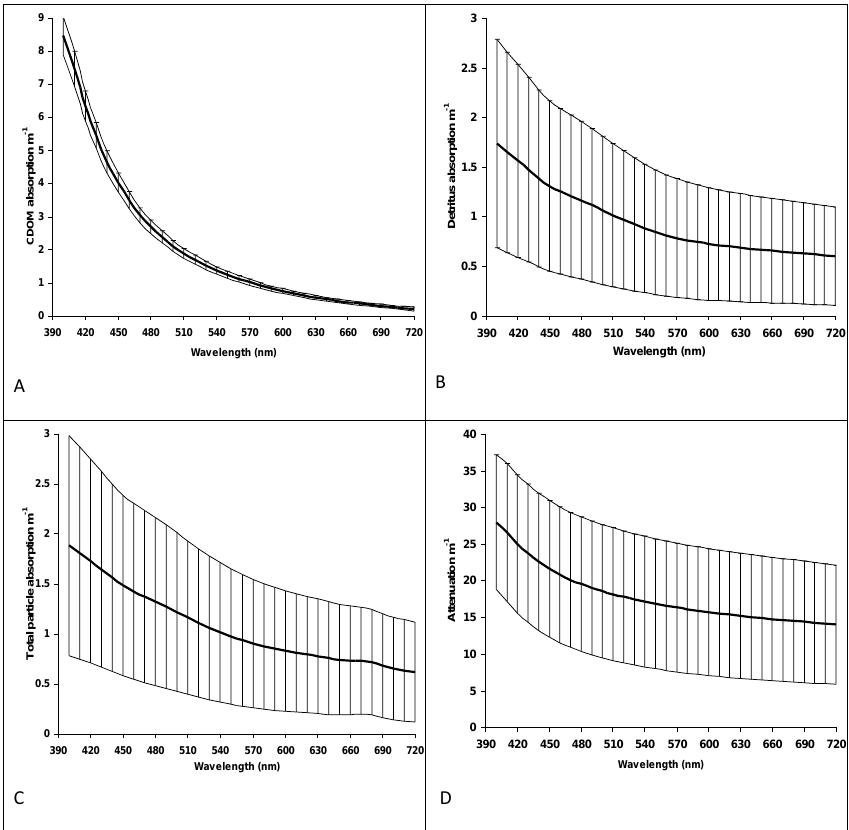
Fig. 2. Mean and standard deviations of the absorption coefficients of (A) CDOM, (B) particulate detritus, and (C) total particulate matter, and (D) of the beam attenuation of the samples.